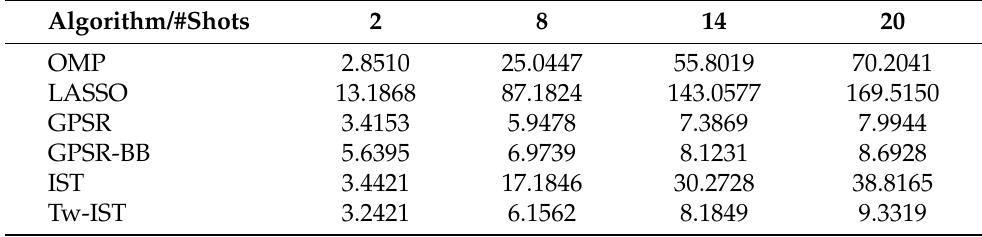
Table 3. Execution time (in seconds) required for the image reconstruction with B = 4, DCT basis, and different algorithms and the number of